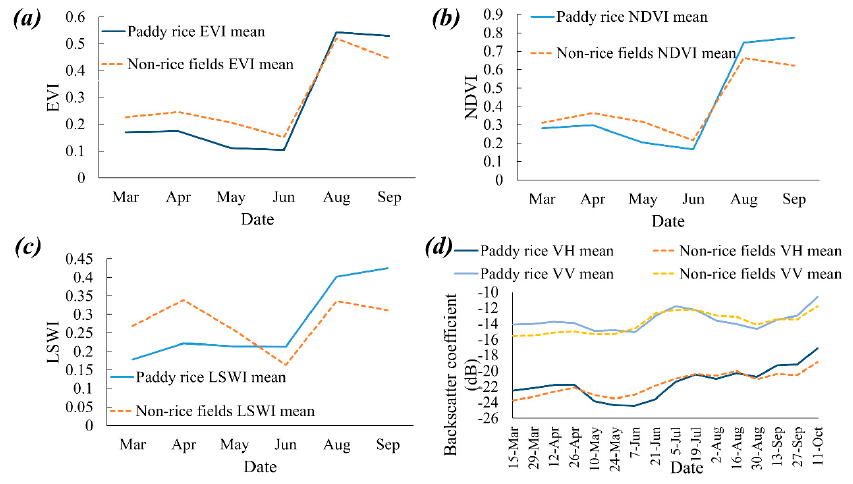
Figure 3. Temporal profile of NDVI, EVI, and LSWI. ( a ). EVI temporal profile. ( b ). NDVI temporal profile. ( c ). LSWI temporal profile. ( d ). The polarization band temporal profile.